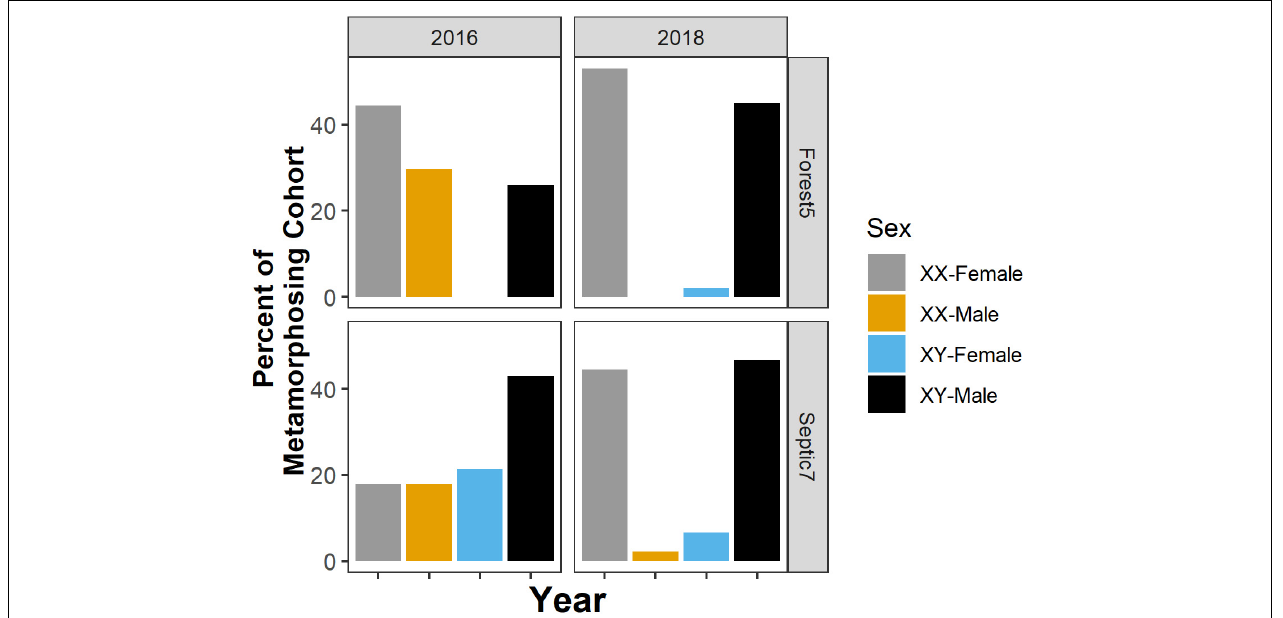
FIGURE 5 | The presence, direction, and frequency of sex reversal in metamorphosing cohorts varies between populations and among years within a population. Sexual genotype-phenotype data from two focal ponds – Forest5 and Septic7 – in the years 2016 and 2018. Orange and blue bars represent frequencies of sex-reversed metamorphs and gray and black bars represent non-reversed frogs.